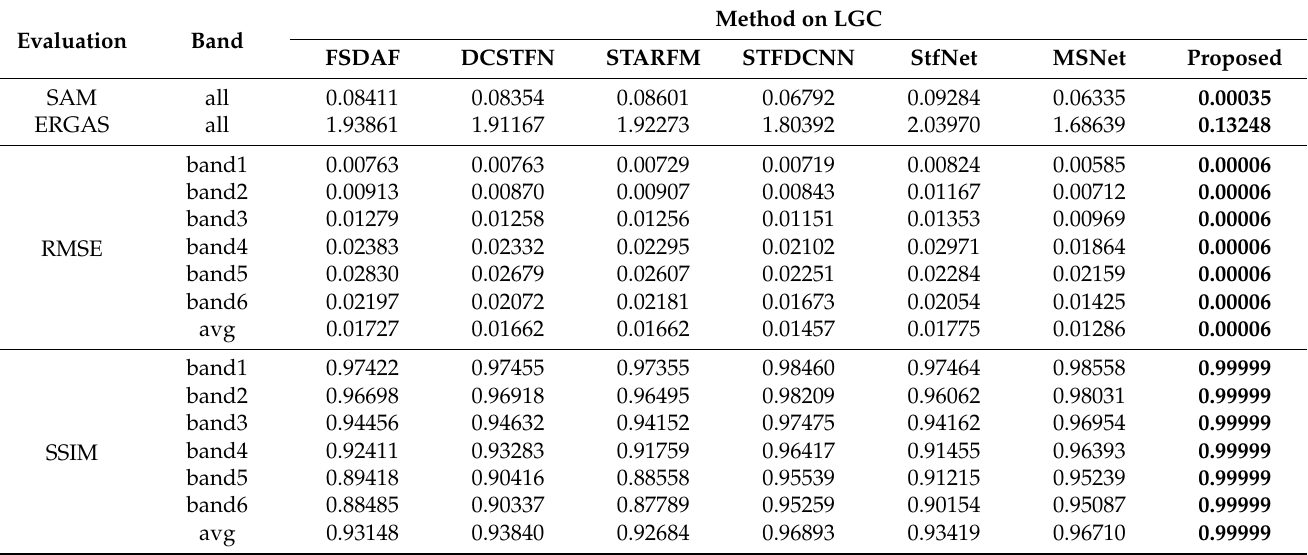
Table 2. Quantitative assessment of various spatiotemporal fusion methods for LGC